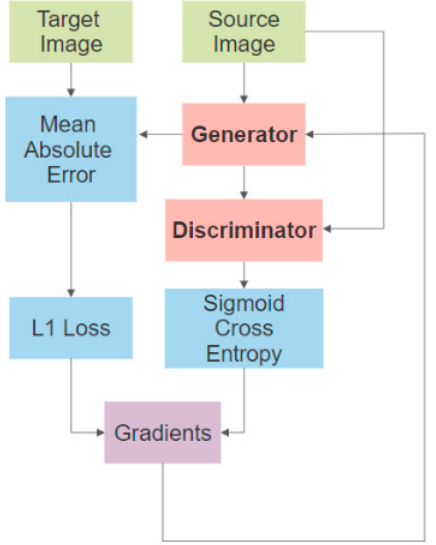
Figure 2. Training procedure for image generator through L1 and GAN loss functions.